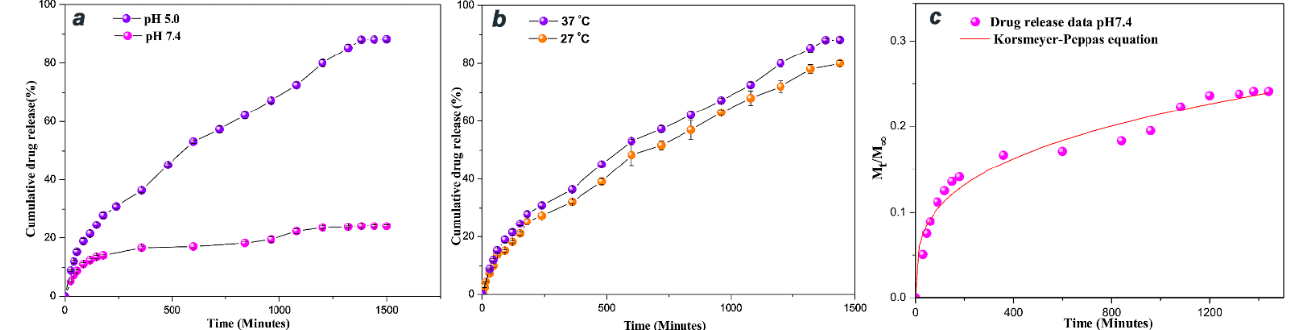
Figure 7. ( a ) pH responsive 5 FU release profile of 5 FU-loaded Fe 3 O 4 -Dex-MA-g-P(NVI/NVCL) at 37 °C at pH of 5.0 and 7.4. Data are presented as mean ± SD (n = 3); ( b ) In vitro 5 FU release of profile of 5 FU-loaded Fe 3 O 4 -Dex-MA-g-P(NVI/NVCL) at pH 5.0, temperatures 27 and 37 °C. Data are presented as mean ± SD (n = 3); ( c ) Korsmeyer–Peppas fit for 5 FU release from 5 FU-loaded Fe 3 O 4 -Dex-MAg-P(NVI/NVCL) at pH 7.4. Reprinted/adapted from ref. [322] with permission from Elsevier,